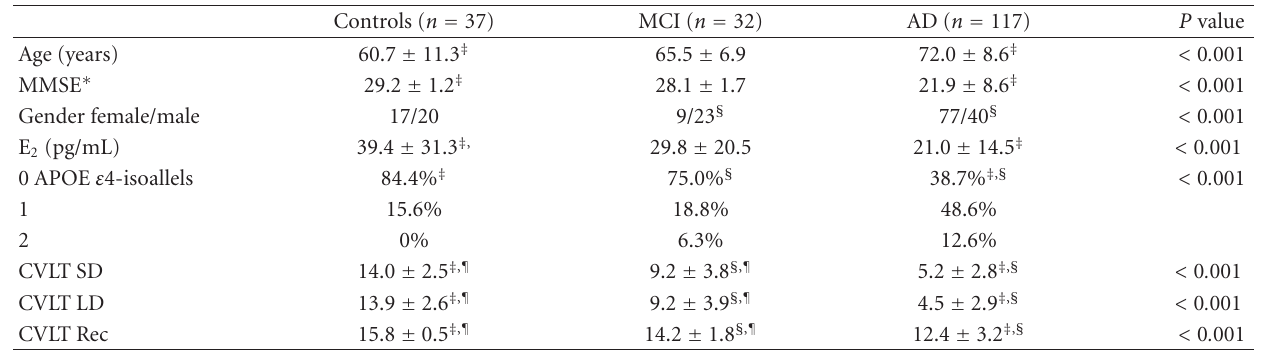
Table 1: Demographic and clinical data of study subjects.